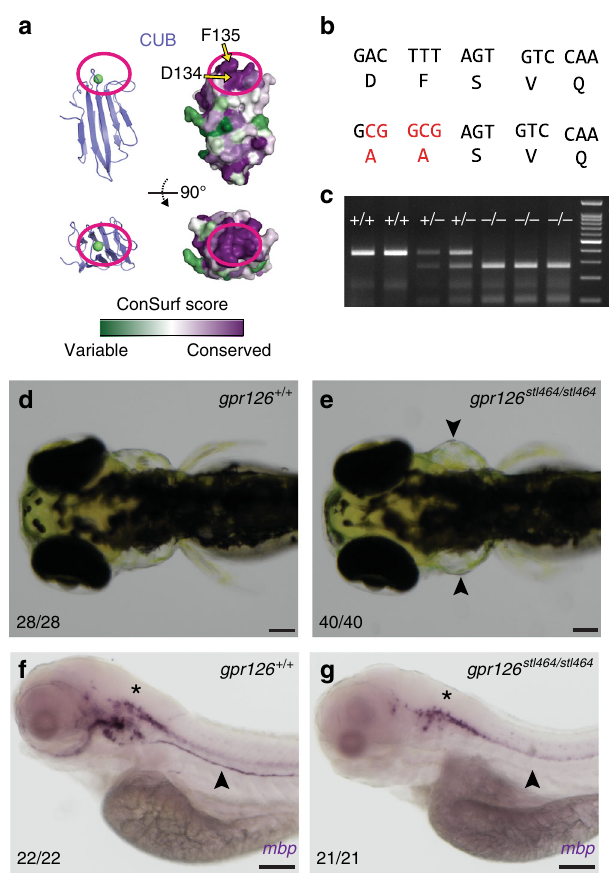
Fig. 5 The calcium-binding site is required for Gpr126 function in vivo. a Surface conservation analysis (green, variable; purple, conserved) of CUB domain. The calcium-binding site is circled in magenta. D134 and F135 are indicated by arrows. b D134 and F135 were both mutated to alanines through homologous recombination of a 150 bp ssODN containing a 5 bp mutation (red nucleotides). c Genotyping assay for the gpr126 stl464 lesion. The 5 bp mutation introduces a BstUI restriction enzyme binding site. d 4 dpf wild-type larva compared to e 4 dpf gpr126 stl464/stl464 larva with puffy ears (arrowheads). Scale bars (black) represent 100 μ m. f 4 dpf wild-type larvae express mbp throughout the posterior lateral line nerve (PLLn, arrowhead), whereas g 4 dpf gpr126 stl464/stl464 larva lack mbp expression along the PLLn (arrowhead). Scale bars (black) represent 100 μ m. Asterisks indicate